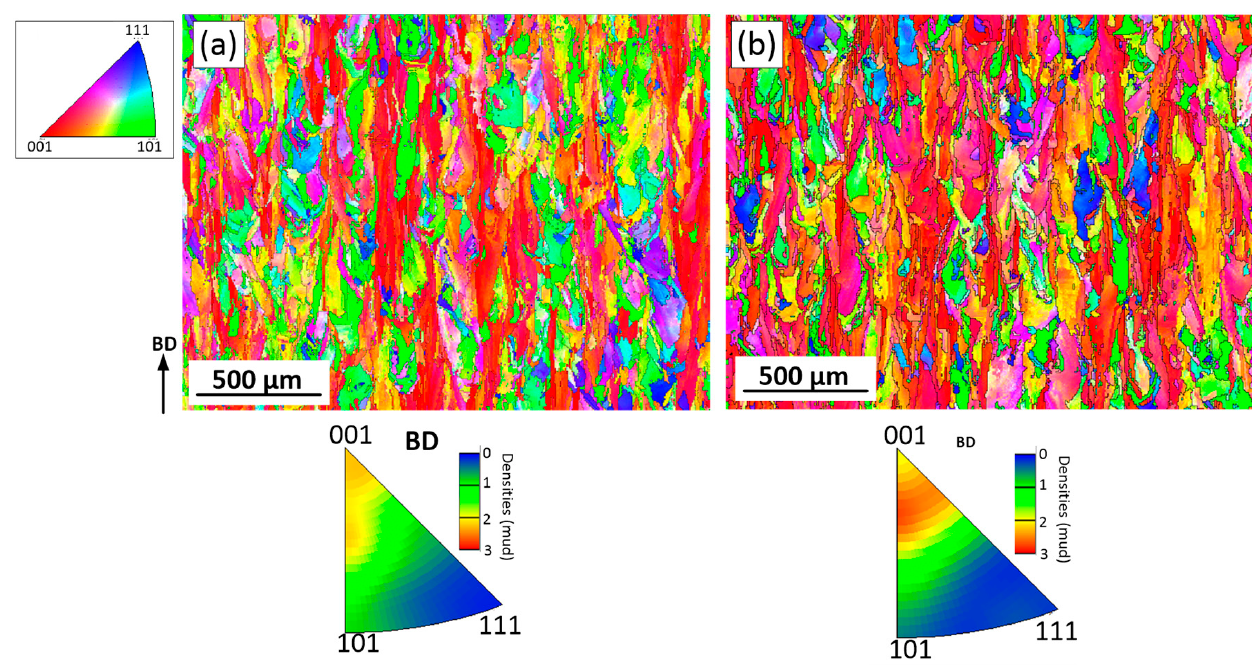
Figure 7. Orientation image microscopy (OIM) maps and inverse pole figures (IPFs) in the ZX plane of the as-built ( a ) Alloy 1 and ( b ) Alloy 2.